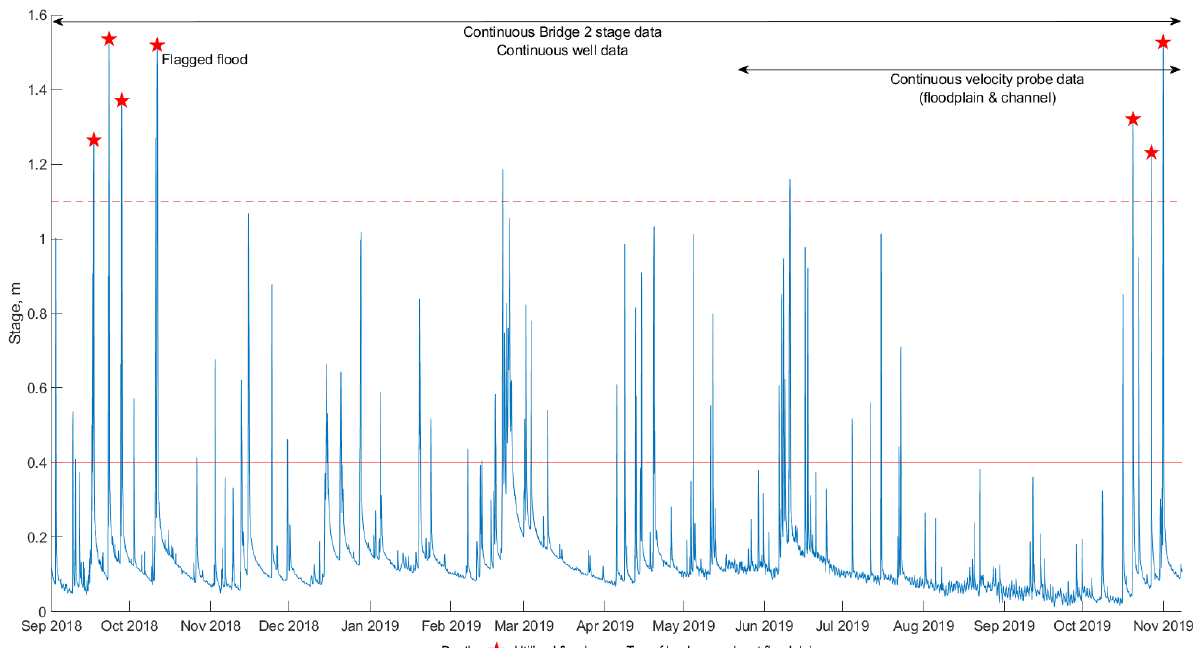
Figure 2. Stage hydrograph recorded at Bridge 2 of StREAM Lab with the seven utilized floods and the durations of sensor data collection.